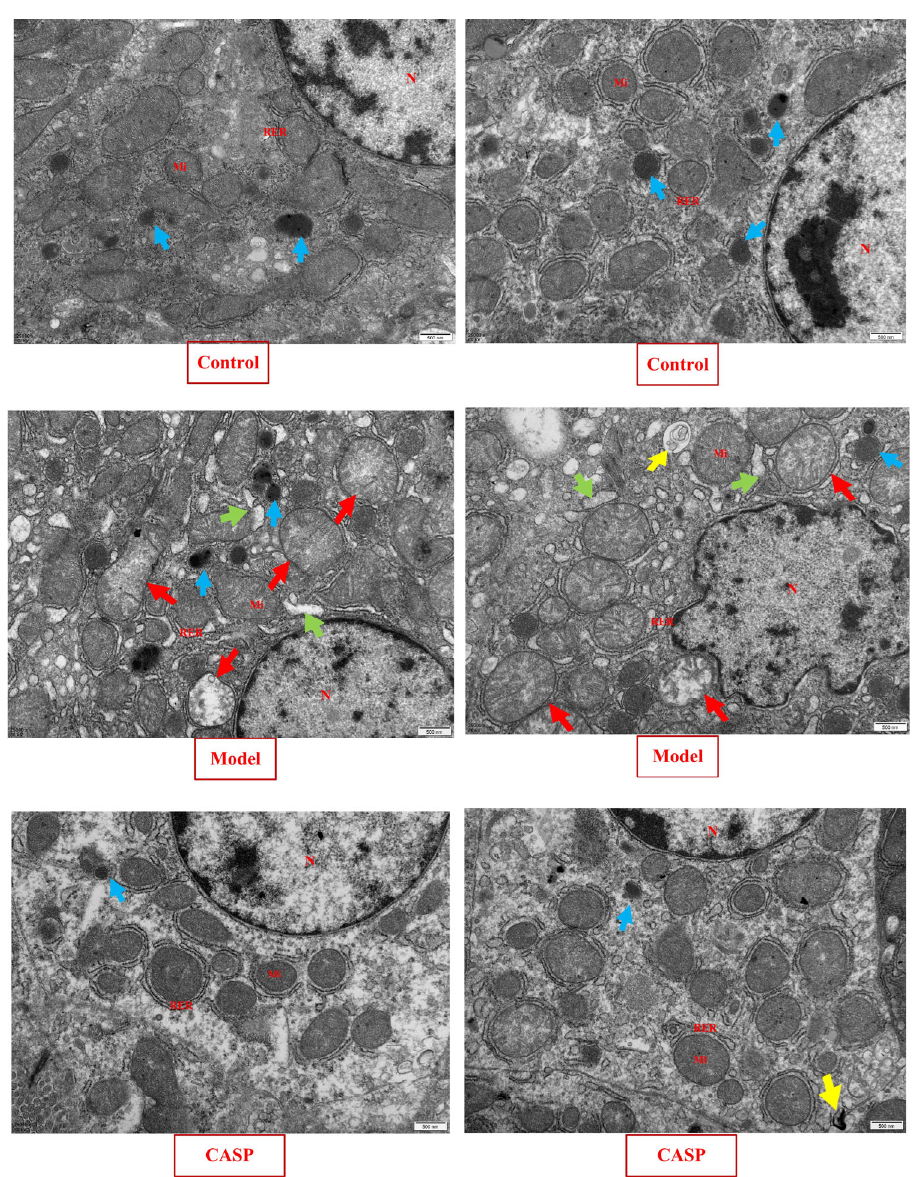
Figure 2. Transmission electron microscopy observation results of chicken liver in each group (25,000 × ). Note: Nucleus (N), Mitochondria (Mi), Rough endoplasmic reticulum (RER), Primary lysosome ( ↑ ), Rough endoplasmic reticulum dilates ( ↑ ), Mitochondrial swelling ( ↑ ), autophagy ( ↑ ). In the normal control group, the morphology and structure of the hepatocytes in the chicken liver were normal, the structure of the organelles in the cytoplasm was complete and clear, no obvious lesions were found, and a small amount of primary lysosomes were occasionally seen. In the model group, the liver nuclei in the chicken liver were mostly